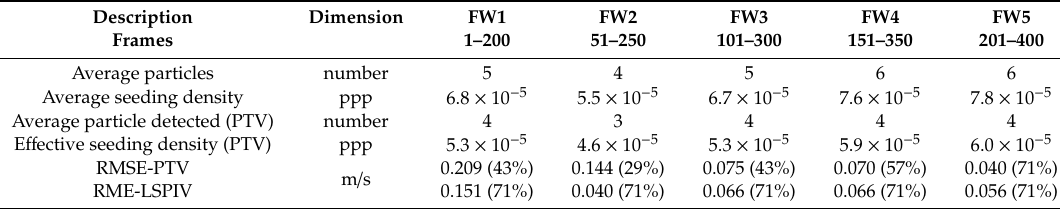
Table 5. Average seeding characteristics of frame sequences with indication of RMSE computed with di ff erent techniques. Percentage of locations with estimated value using image velocimetry techniques shown in